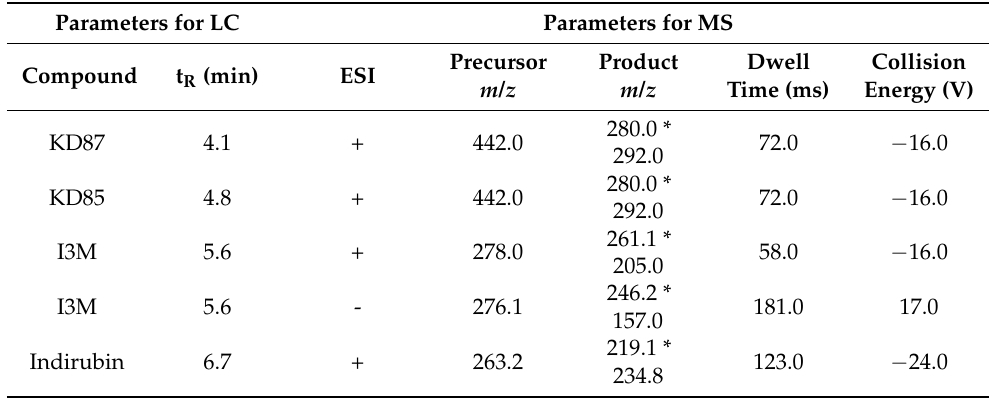
Table 1. Applied mass spectrometer and source parameters. m / z quantifiers are marked with *, retention time (t R ), mass-to-charge-ratio ( m / z ), milliseconds (ms), and volt